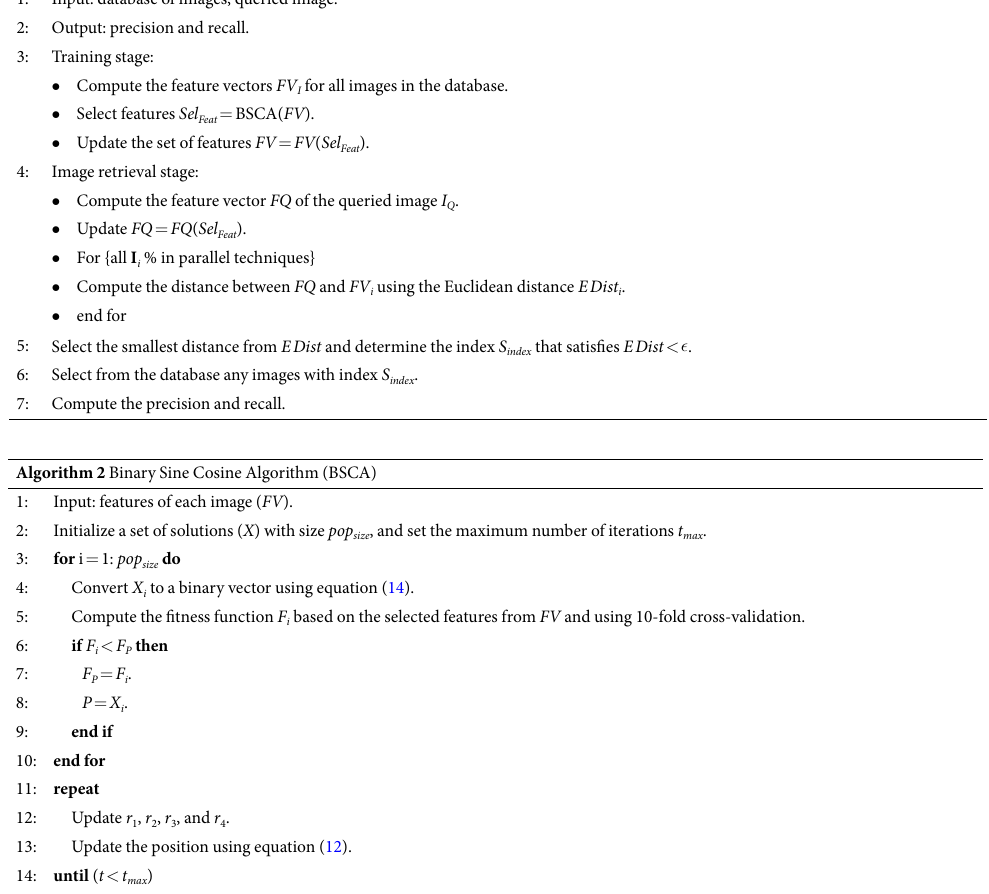
Algorithm 1 The Proposed approach For Galaxy Image